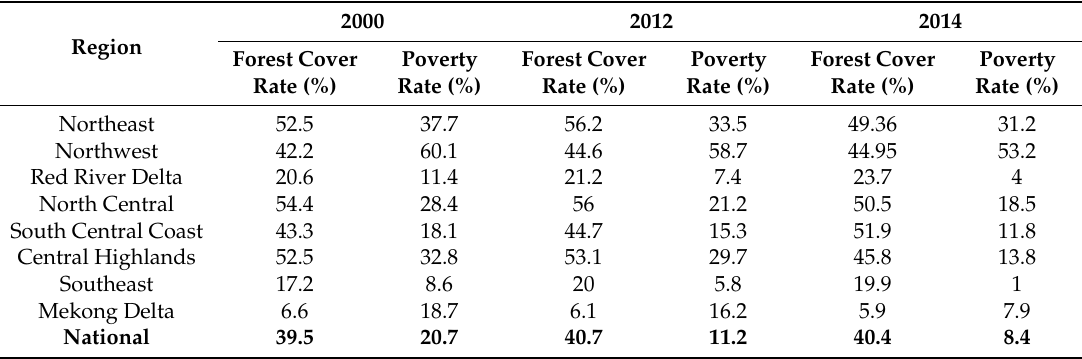
Table 4. Linkage of forest cover and poverty in Vietnam, 2000 to